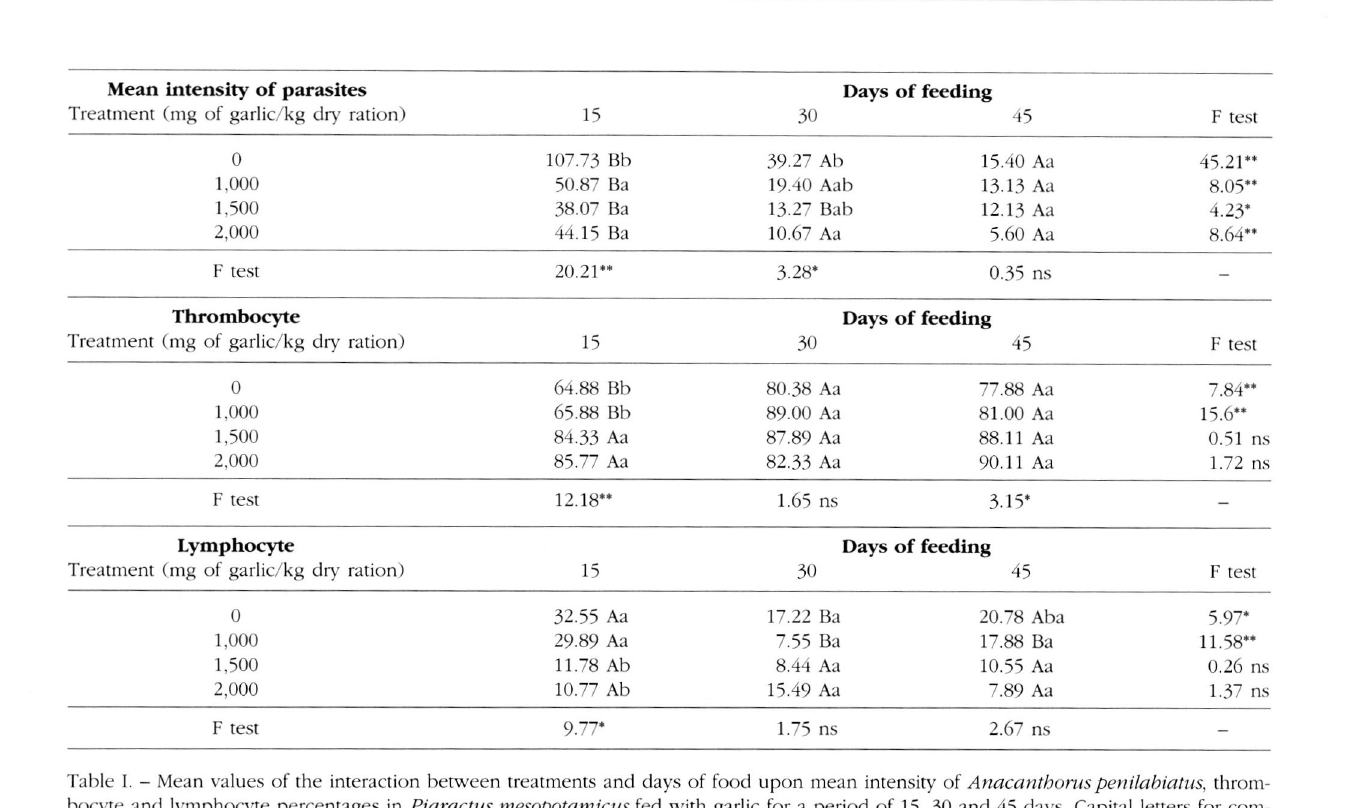
Table I. - Mean values of the interaction between treatments and days of food upon mean intensity of Anacanthorus penilabiatus, throm bocyte and lymphocyte percentages in Piaractus mesopotamicus fed with garlic for a period of 15, 30 and 45 days. Capital letters for com parison between days of feeding and minuscule letters for comparison between treatments (ns: not significant, ** P < 0.05. ** P < 0.01).